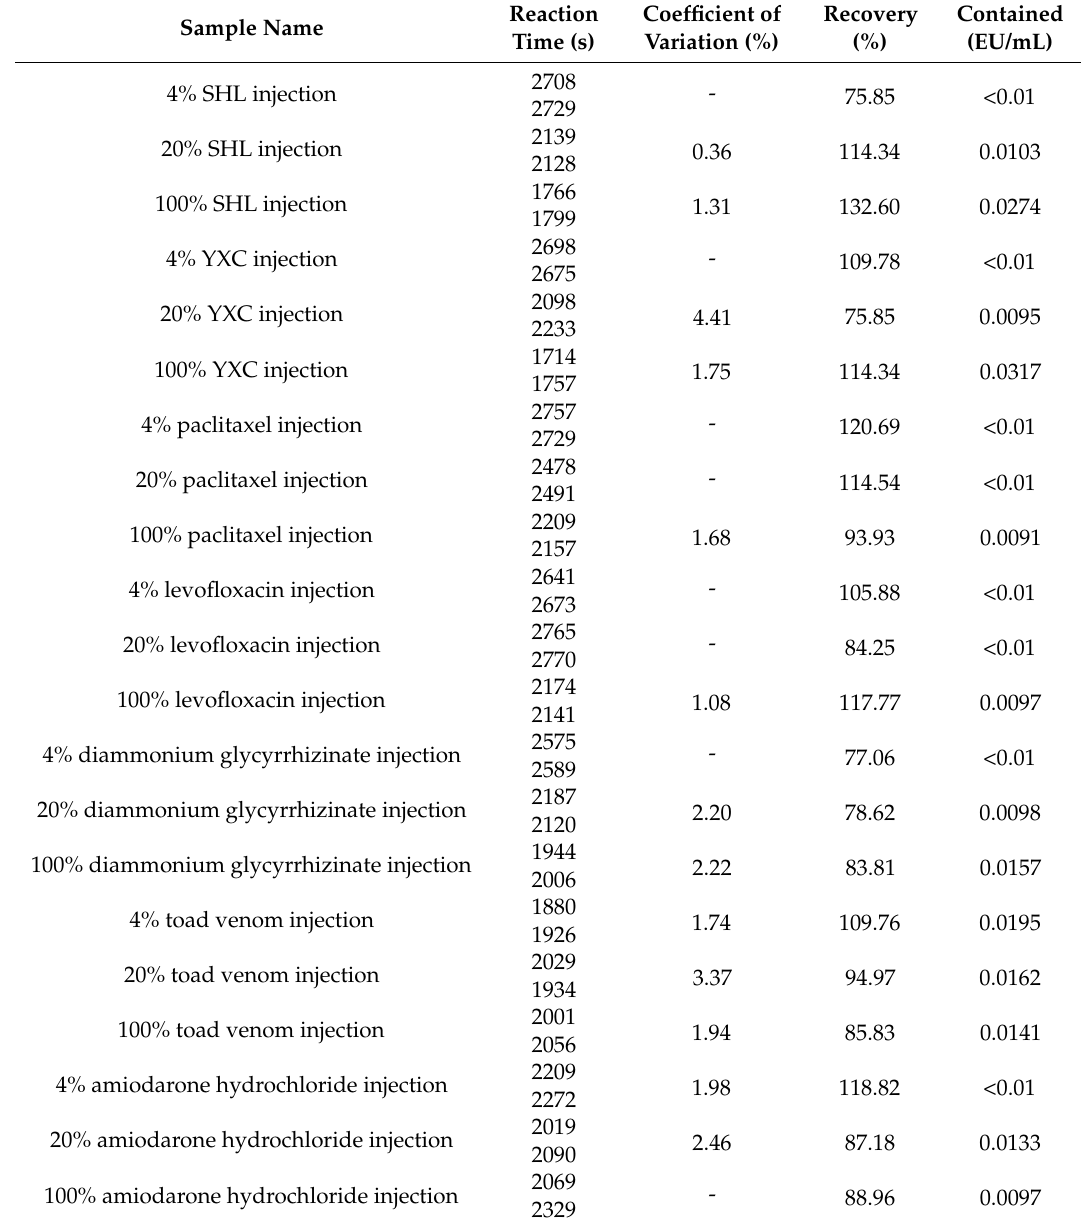
Table 3. Endotoxin concentration in each